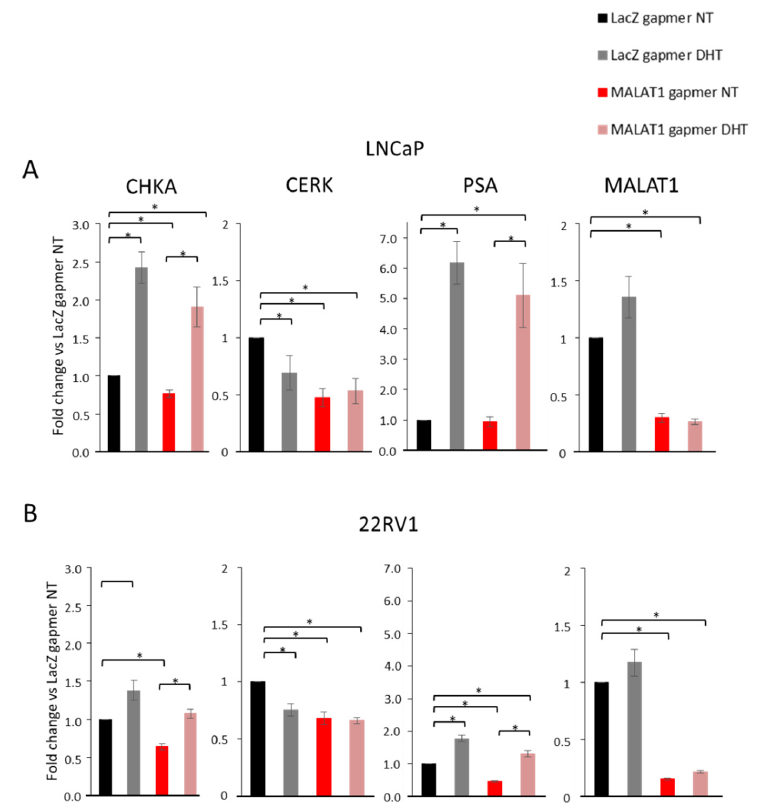
Figure 6. Effects on CHKA expression in MALAT1-depleted PCa cells combined with Dihydrotestosterone (DHT) treatment: ( A , B ) CHKA, CERK, Prostate-specific antigen (PSA), and MALAT1 transcript levels quantified after MALAT1 gapmer transfection in LNCaP (16 h of transfection), ( A ) and 22RV1 (24 h of transfection), ( B ) cells treated with or without DHT (10 –6 M for LNCaP and 10 –8 M for 22RV1) for 16 h. Data are represented as mean of fold change vs. LacZgapmer ± SEM (LNCaP N = 5; 22RV1 N = 4). * p <